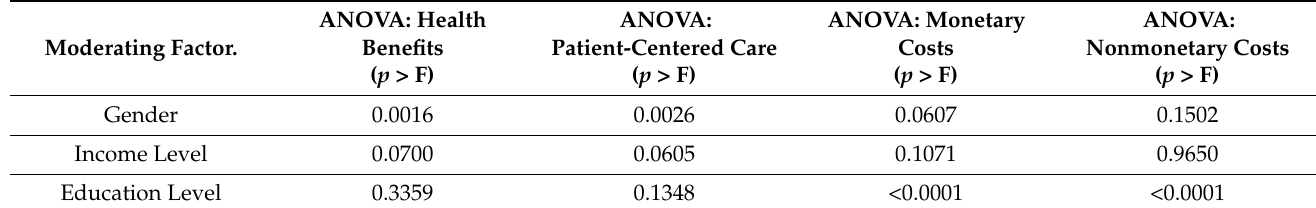
Table 2. ANOVA Results for Dimensions of Patient Satisfaction.